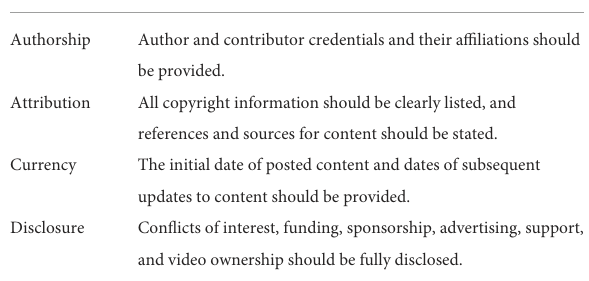
TABLE 2 Global Quality Score criteria